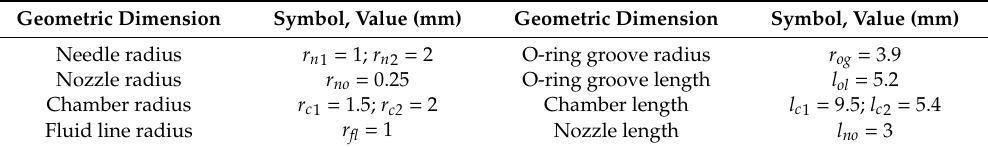
Table 1. Main geometric dimensions of experiment jet valve.